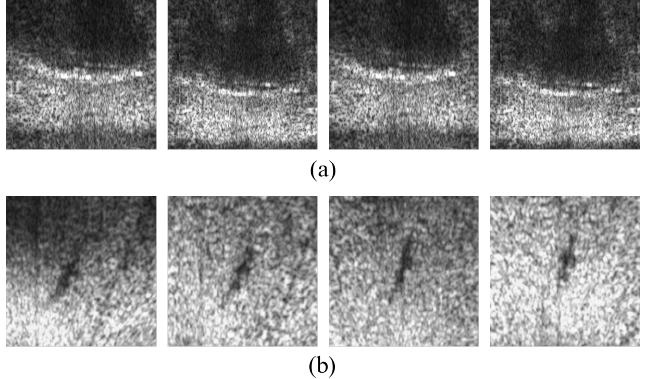
Figure 11. Sample images of ( a ) TDI-2017 and ( b ) TDI-2018 that failed to be classified into the label of body.